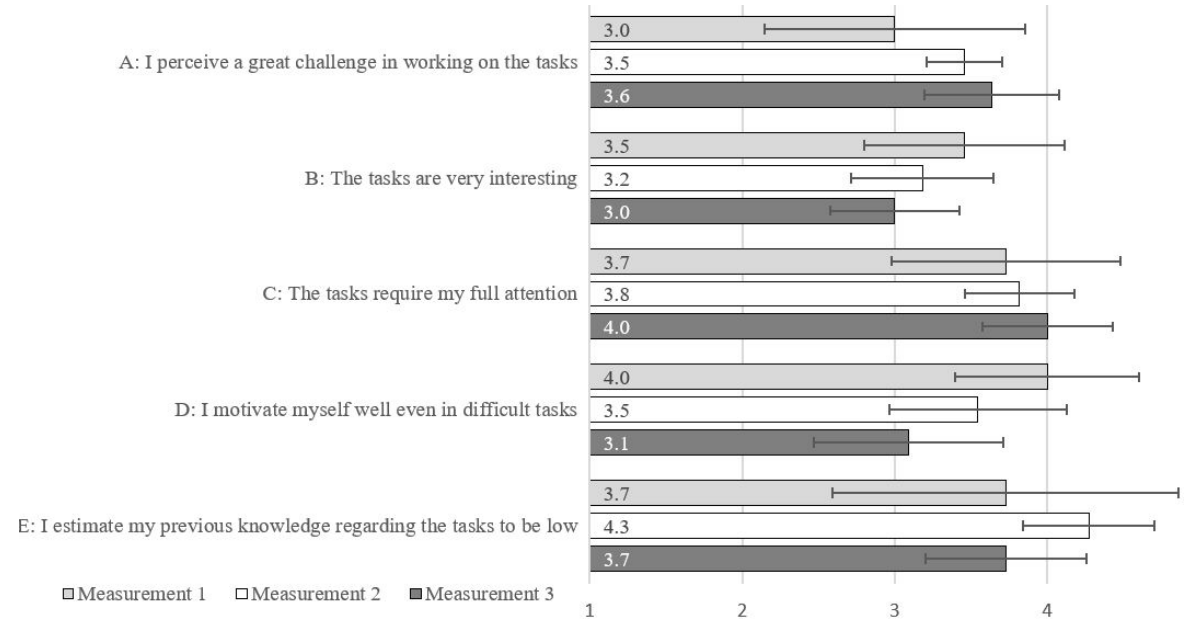
Figure 2. Items regarding task attractiveness and measurements ( n = 11).